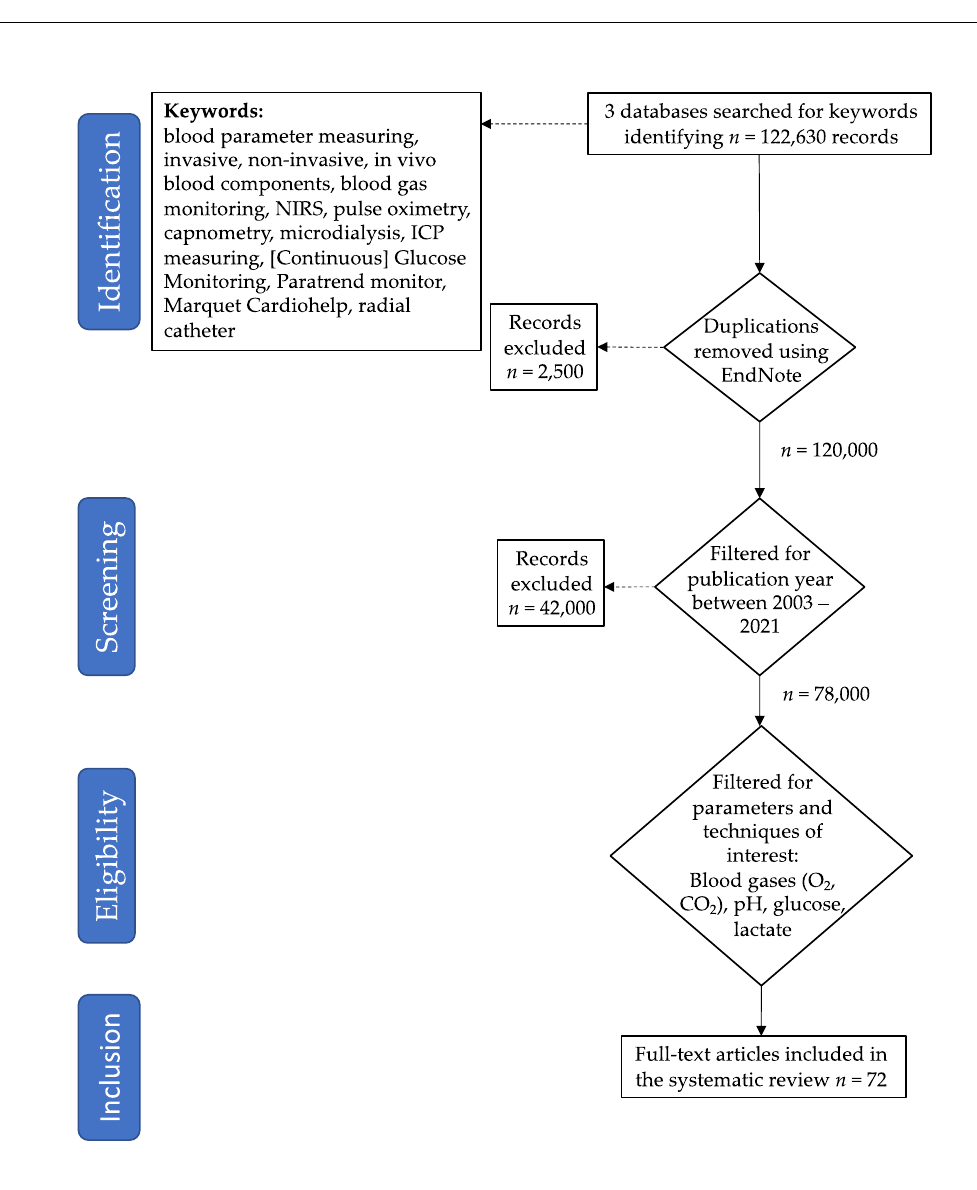
Figure 1. Literature search method used in this review